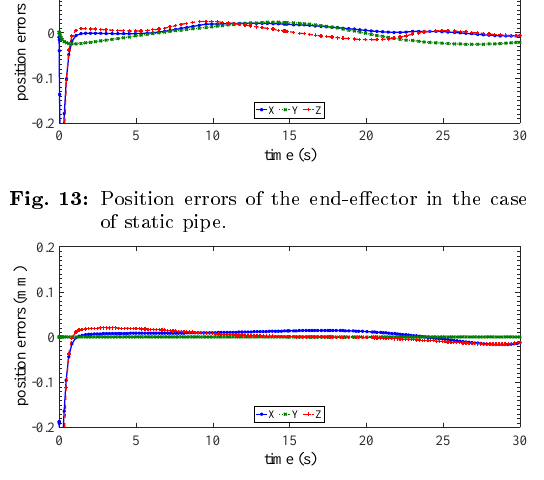
Fig. 14: Position errors of the end-e(cid:27)ector in the case of rotary pipe.